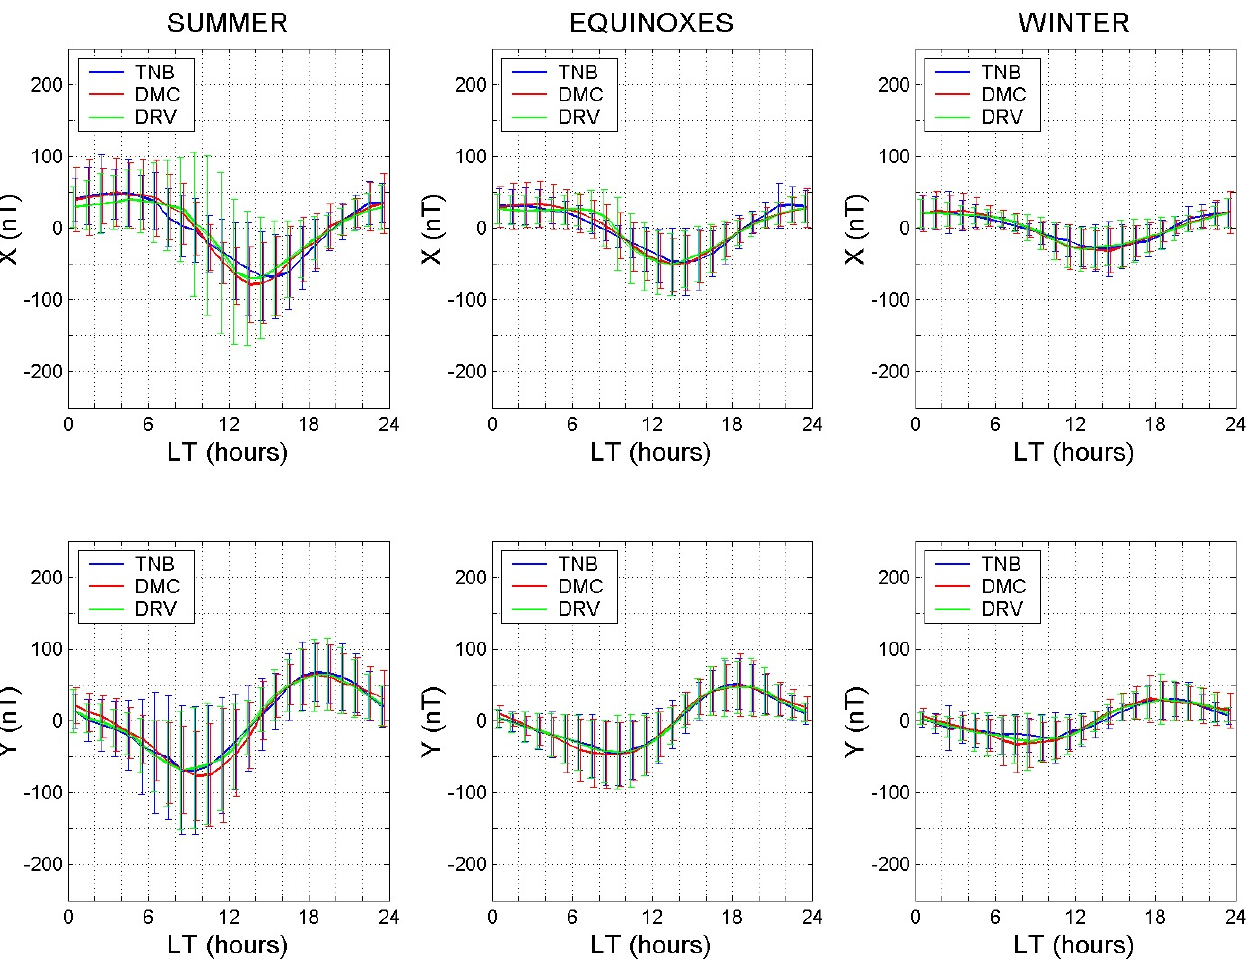
Fig. 6. Daily distribution of the average hourly values and their standard deviation for the X and Y components, considering separately the three Lloyd